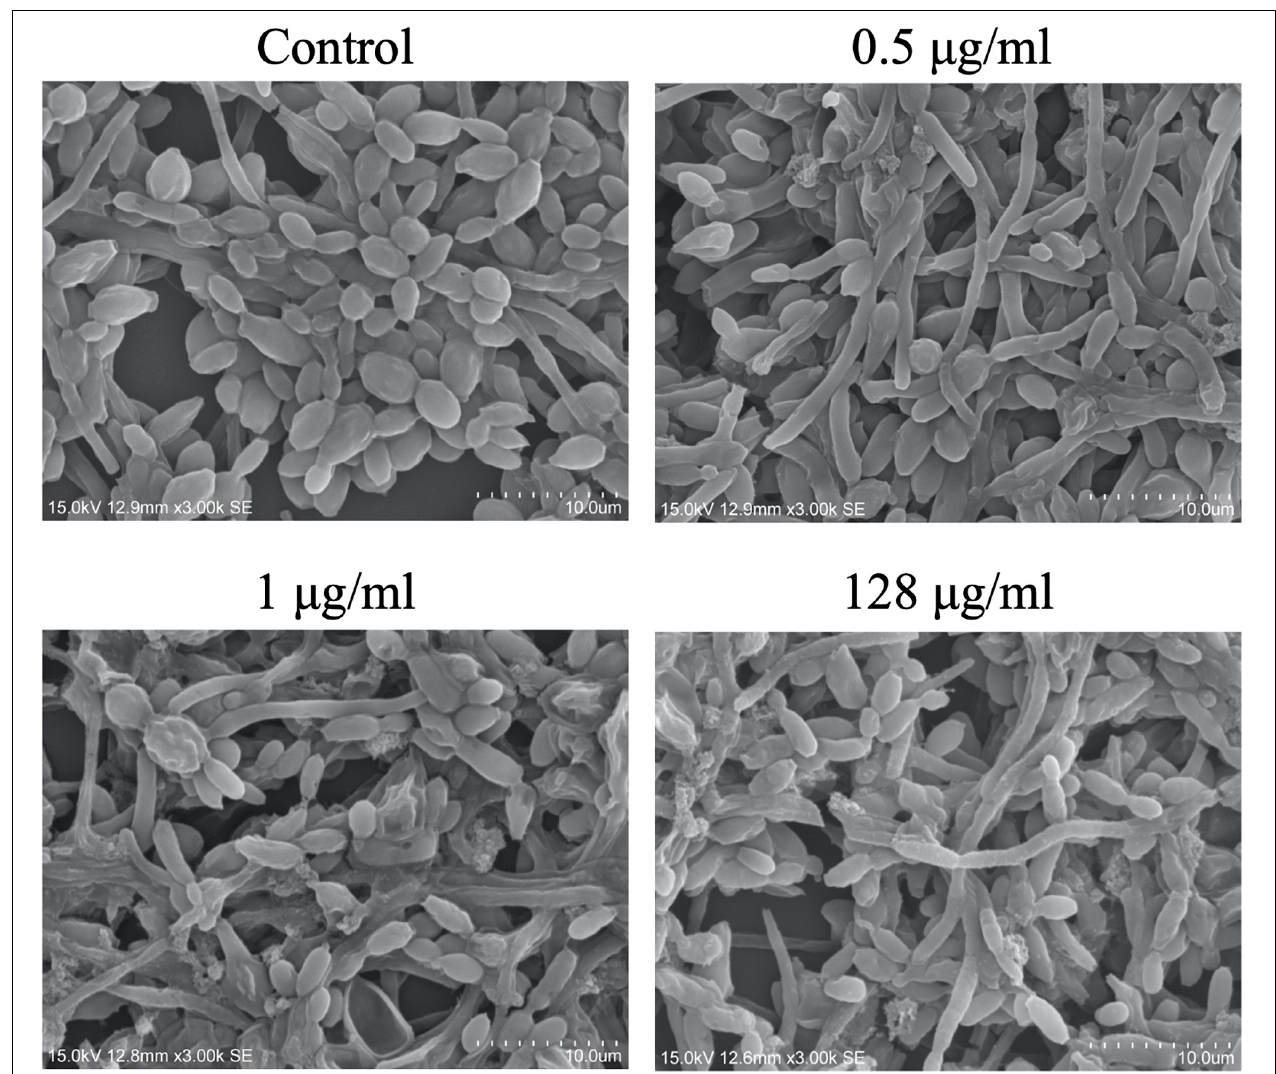
FIGURE 2 | Scanning electron microscopy images of CAS-treated C. albicans biofilms for 24 h. One representative field out of two independent ones is presented. Scale bar = 10 µ